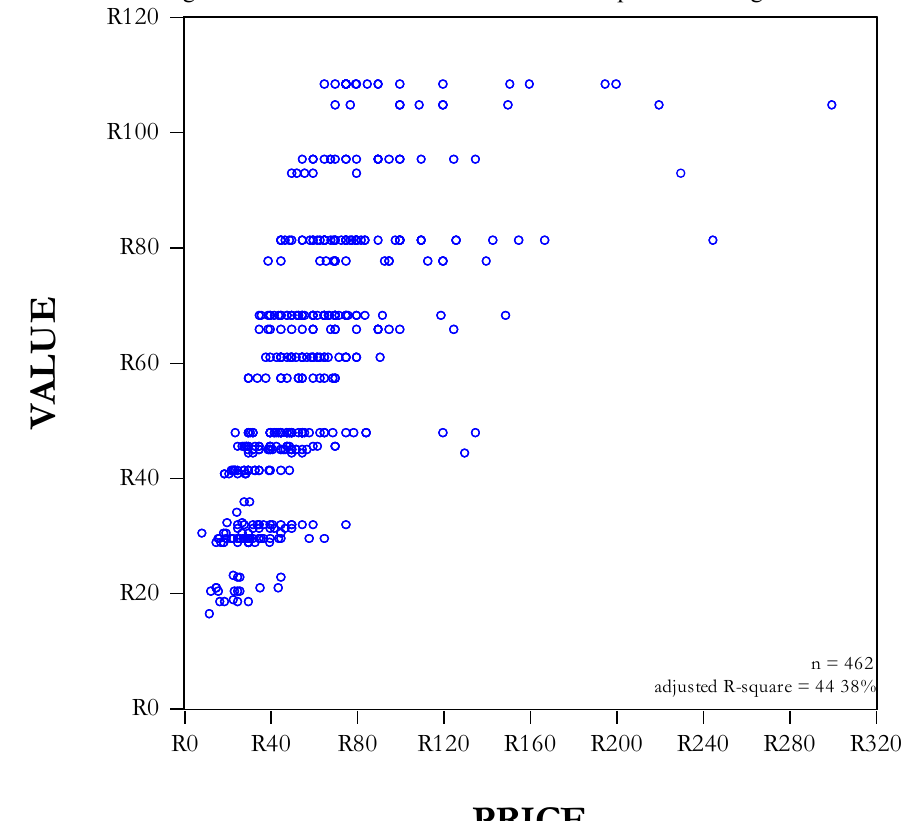
Figure 1: White wines 2007: price versus value: based on blind tastings. This scattergram is derived from the model presented in Table 3. Blind tastings contain no cue bias and are thus reliable predictors of generic ‘no-name brand’ value.